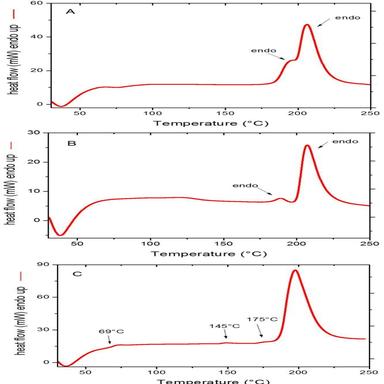
DSC curves for OLZ (a) A, (b) B and (c) C samples at a heating rate of 150 °C.min−1 .